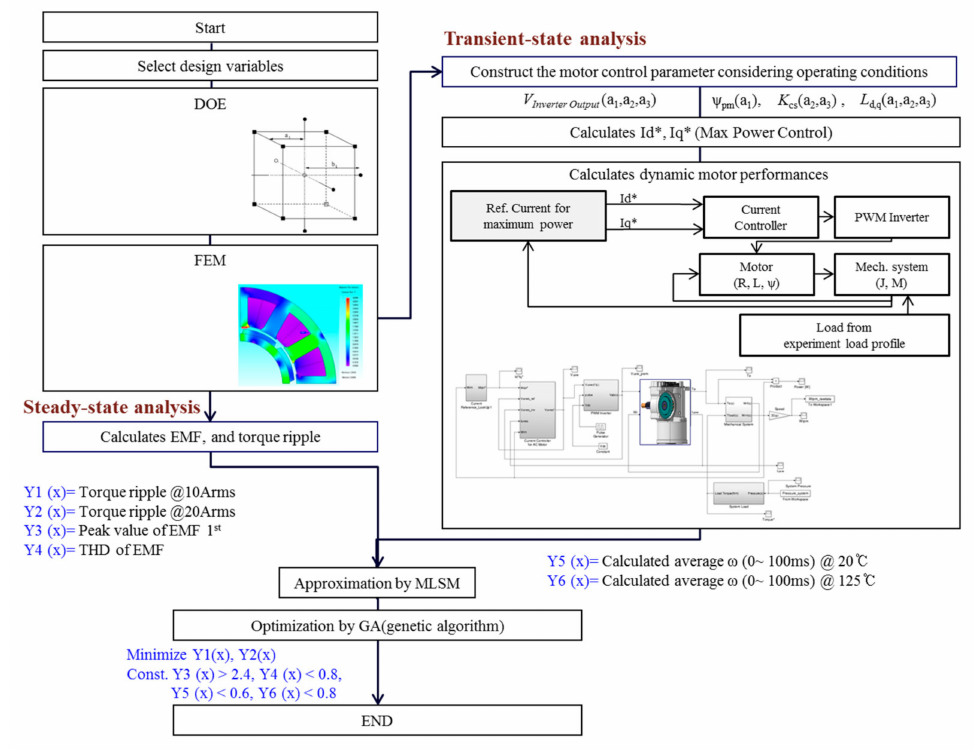
Figure 6. Optimal design